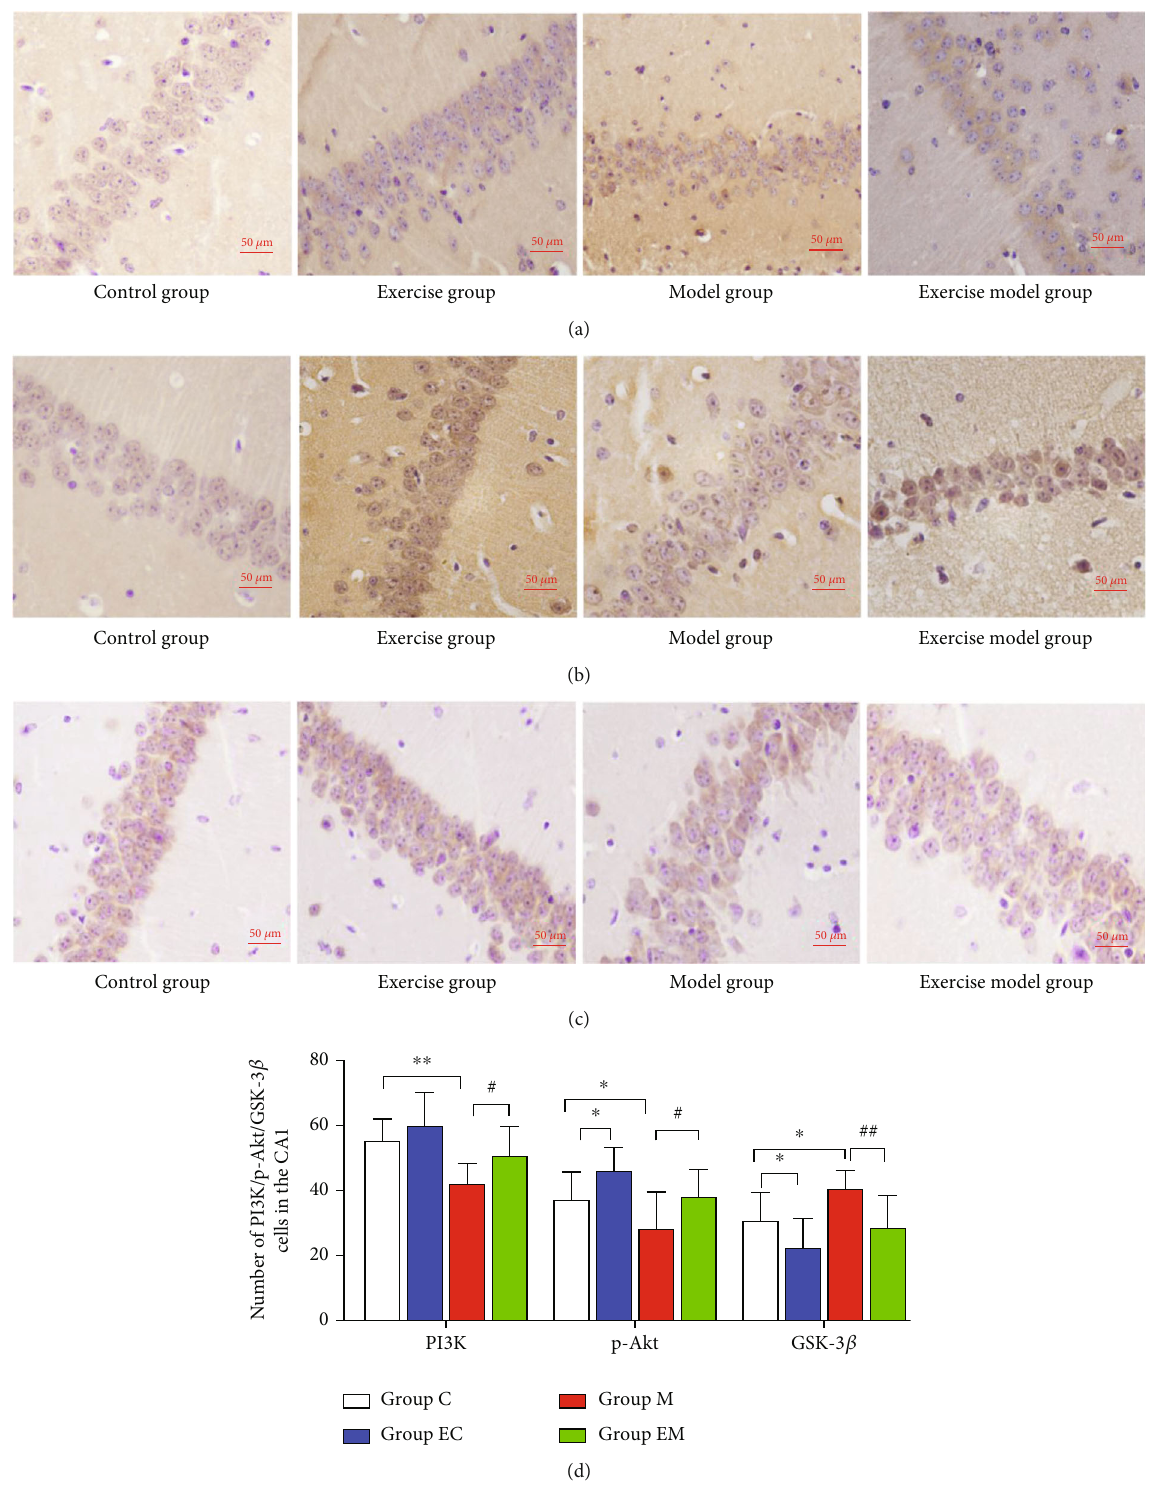
Figure 3: Number of PI3K-, p-Akt-, and GSK-3 β -positive neurons in hippocampal CA1 of each group of mice. (a – c) PI3K, P-Akt, and GSK-3 β immunohistochemical results of the hippocampal CA1 region in each group. (d) The number of immunohistochemical-positive cells in the hippocampal CA1 area of each group. Results are mean ± SD ( n = 8/group ). ∗ P < 0 : 05 and ∗∗ P < 0 : 01 vs. group C; # P < 0 : 05 and ## P < 0 : 01 vs. group M. Scale bar: 50 μ